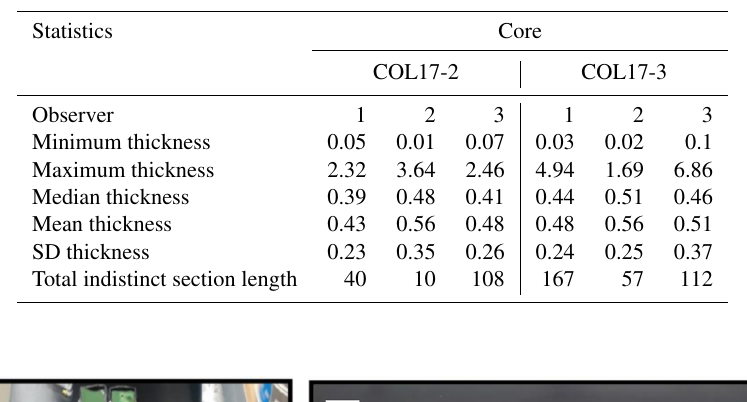
Table A2. Observer- and core-specific lamination statistics of thickness and counts. Lamination quality codes 4, 5, and 6 are excluded from the analysis except to calculate the cumulative length of indistinct sections. All units are millimeters unless otherwise noted.